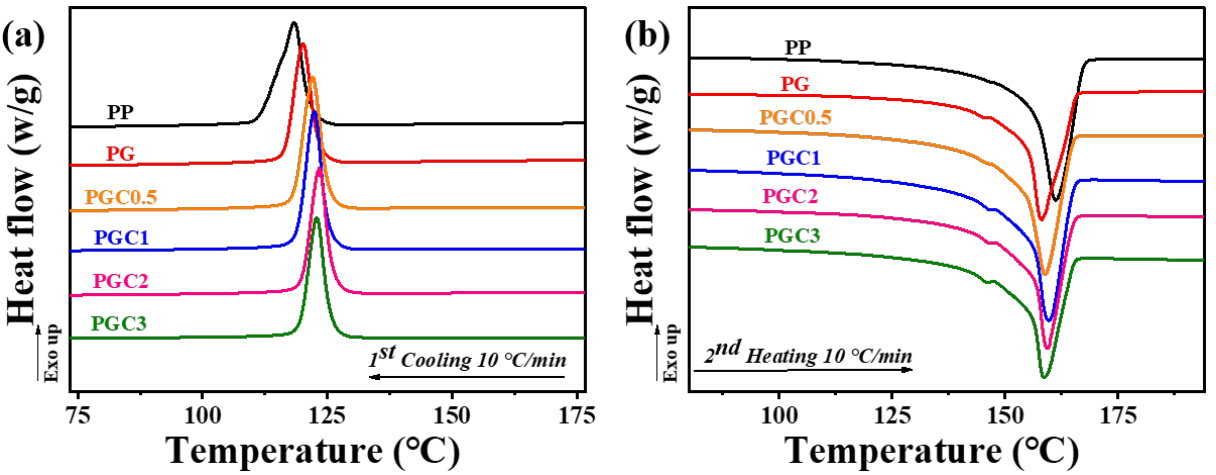
Figure 3. DSC first cooling curves ( a ) and second heating curves ( b ) of PP and the PP/DCP/GMA/C blends with different tea polyphenols (C) loading. Table 2. Thermal parameters measured from the DSC tests for the neat PP and the PP/DCP/GMA/C blends with different tea polyphenols (C) loading.